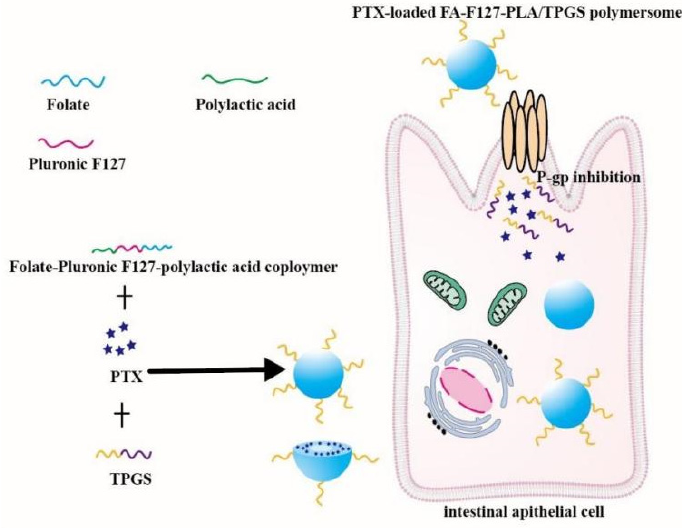
Figure 2. Schematic diagram of PTX-loaded FA-F127-PLA/TPGS mixed polymersome reversing the efflux mediated by P-gp. Remodified and summarized with permission from [70]. Copyright© 2019 Elsevier B.V.